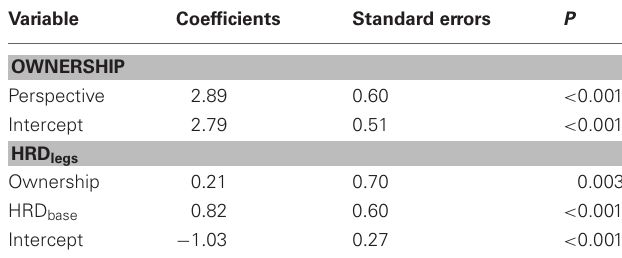
Table 3 | Coefficients, standard errors, and p -values estimates from path analysis applied to the model in Figure 6, using data from experiment